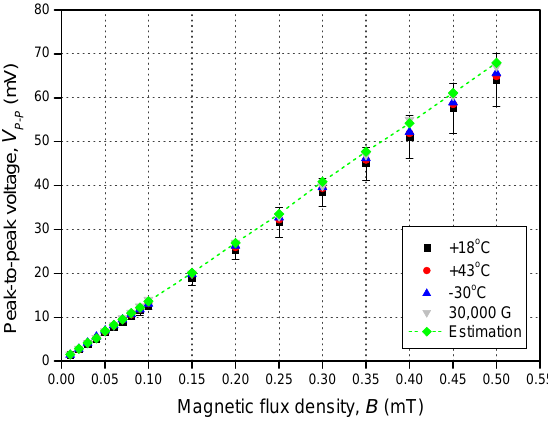
Figure 13. Measured and estimated output signals as function of magnetic flux